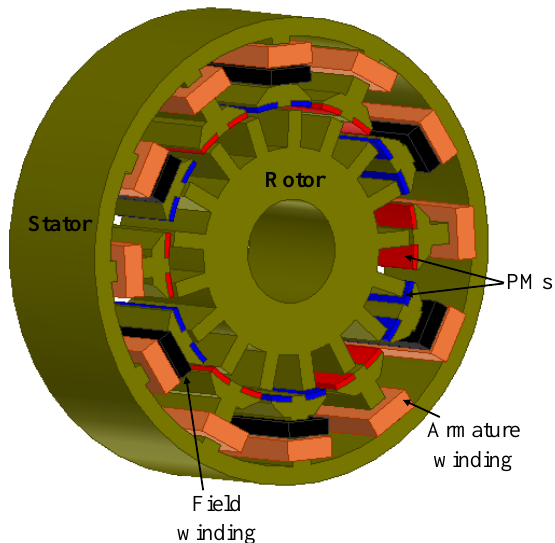
Figure 8. Flux reversal hybrid-excited machine (FRHEM).